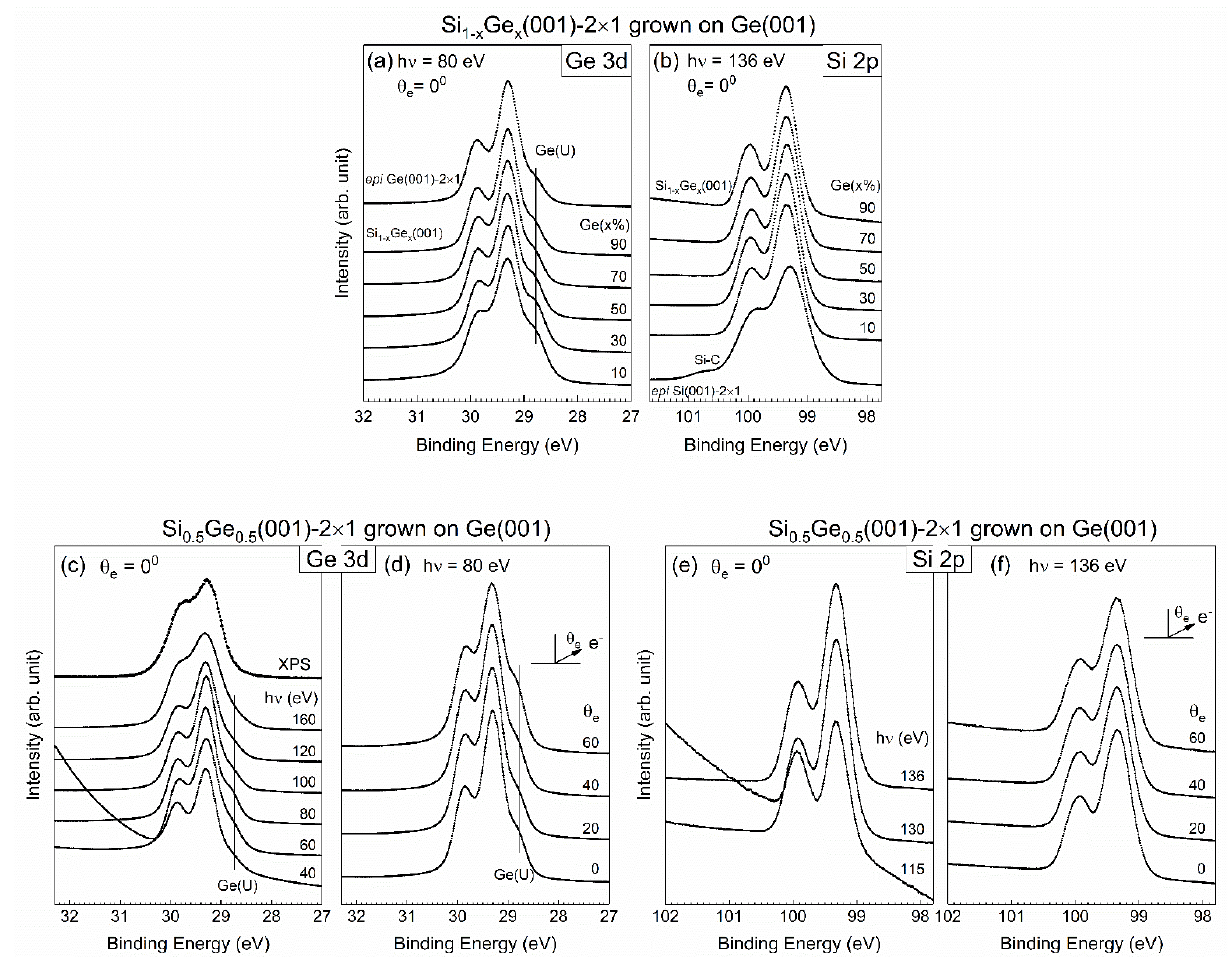
Figure 3. Photoemission data from the as-grown Si 1 − x Ge x (001)-2 × 1 on an epi Ge(001) substrate with the Ge contents ranging from 10% to 90% for the Ge 3d ( a ) and Si 2p ( b ) core-level spectra. The Ge 3d states of the representative x = 50% sample were acquired at ( c ) various photon energies (h ν ) taken under normal emissions ( θ e = 0 ◦ ) at room temperature, as well as at ( d ) various emission angles at h ν = 80 eV. Symbols Ge(U) stand for Ge up-dimer counterpart. The Si 2p states of the representative x = 50% sample were acquired at ( e ) various photon energies (h ν ) taken under normal emissions ( θ e = 0 ◦ ) at room temperature, as well as at ( f ) various emission angles at h ν = 136 eV.